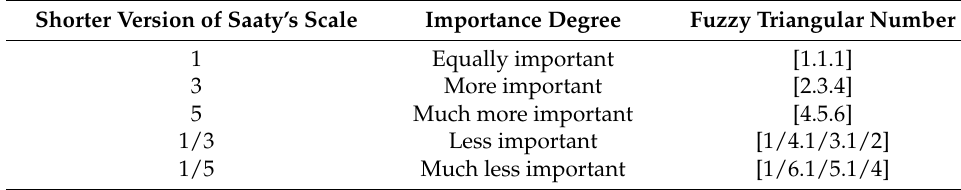
Table 3. Fuzzy triangular numbers employed in FAHP. Shorter Version of Saaty’s Scale Importance Degree Fuzzy Triangular